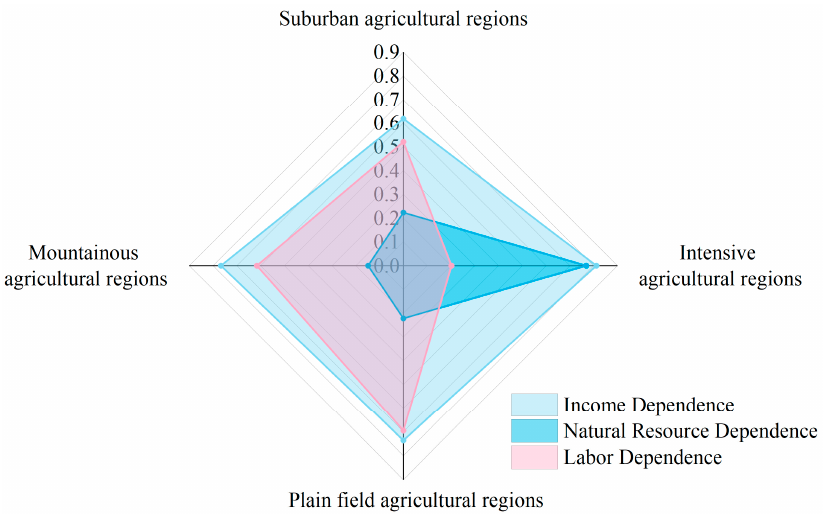
Figure 4. Comparison of income dependence per household in different agricultural regions.